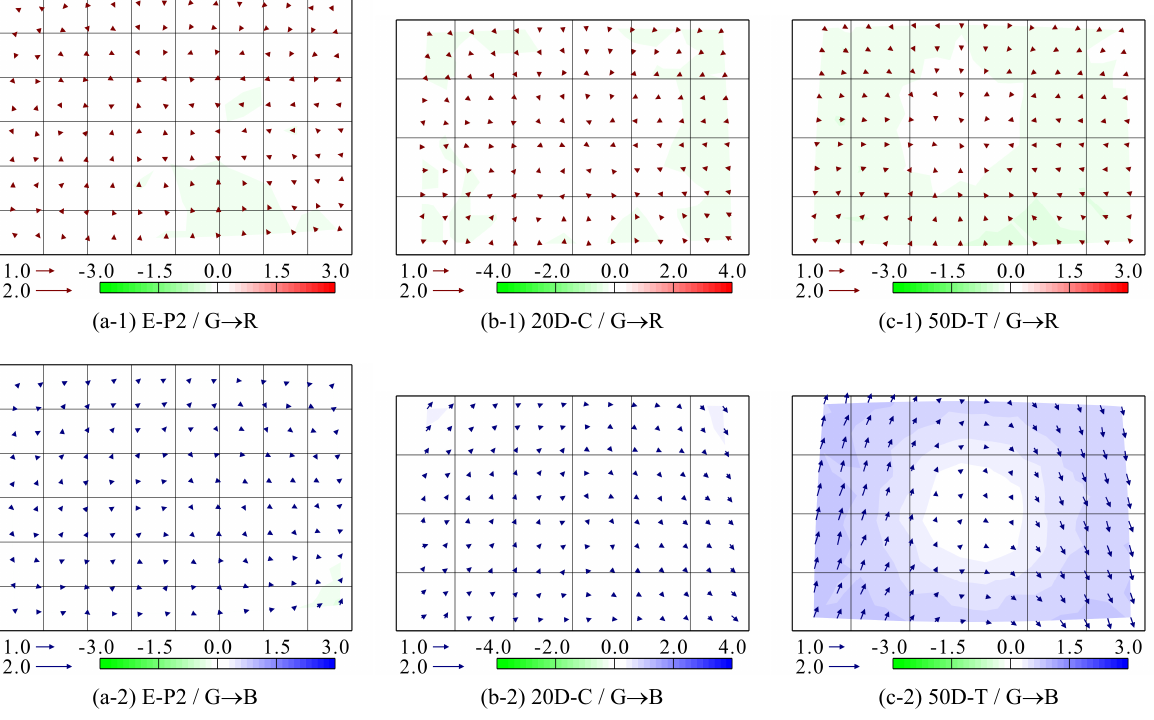
Figure 7. Displacement vectors in the images corrected by the Type B-3 (Unit: pixel)